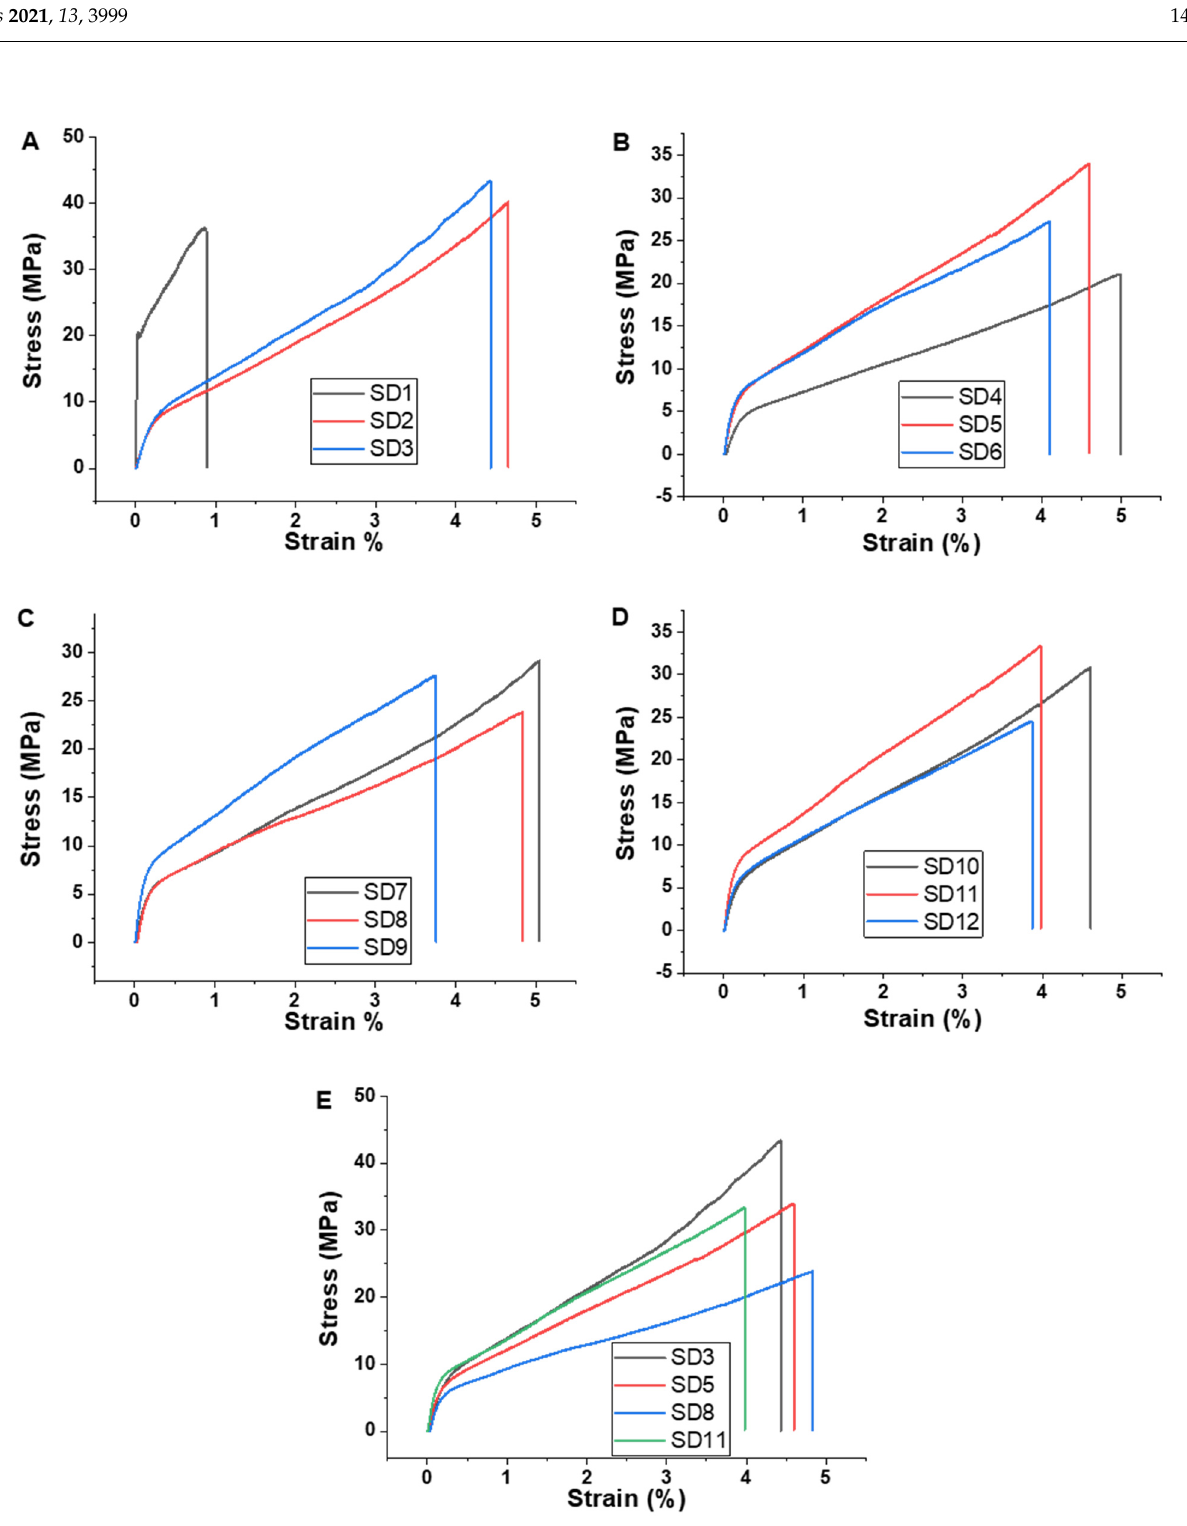
Figure 4. Tensile tests results for the polymer films: ( A ) SD1, SD2, SD3; ( B ) SD4, SD5, SD6; ( C ) SD7, SD8, SD9; ( D ) SD10, SD11, SD12; ( E ) SD3, SD5, SD8, SD11.